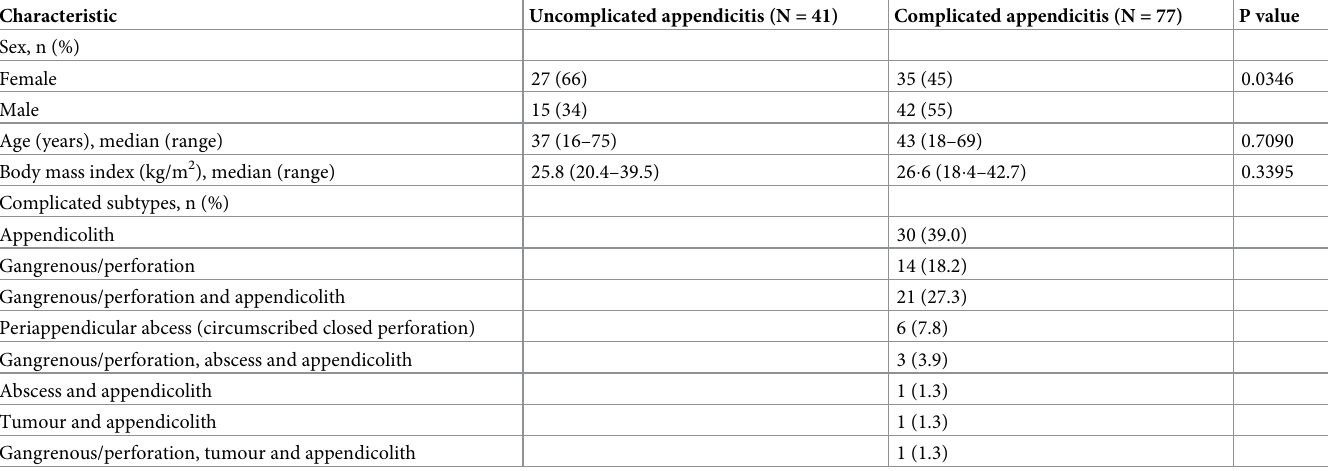
Table 1. Patient baseline characteristics and subtypes of complicated